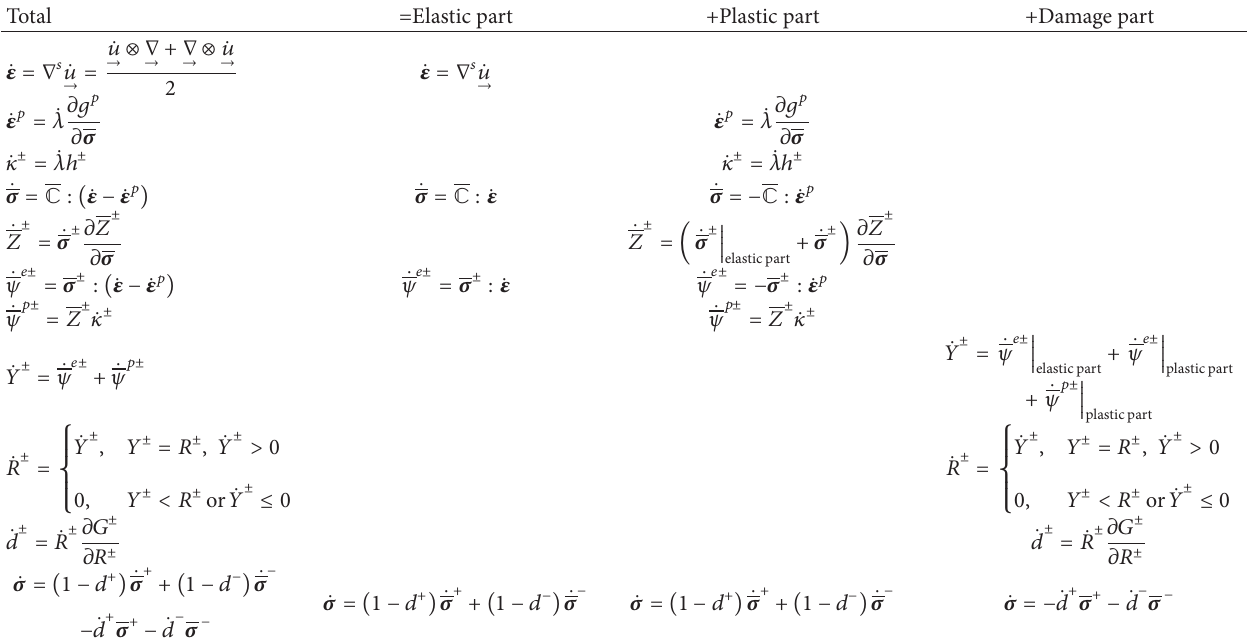
Table 1: Split of rate constitutive